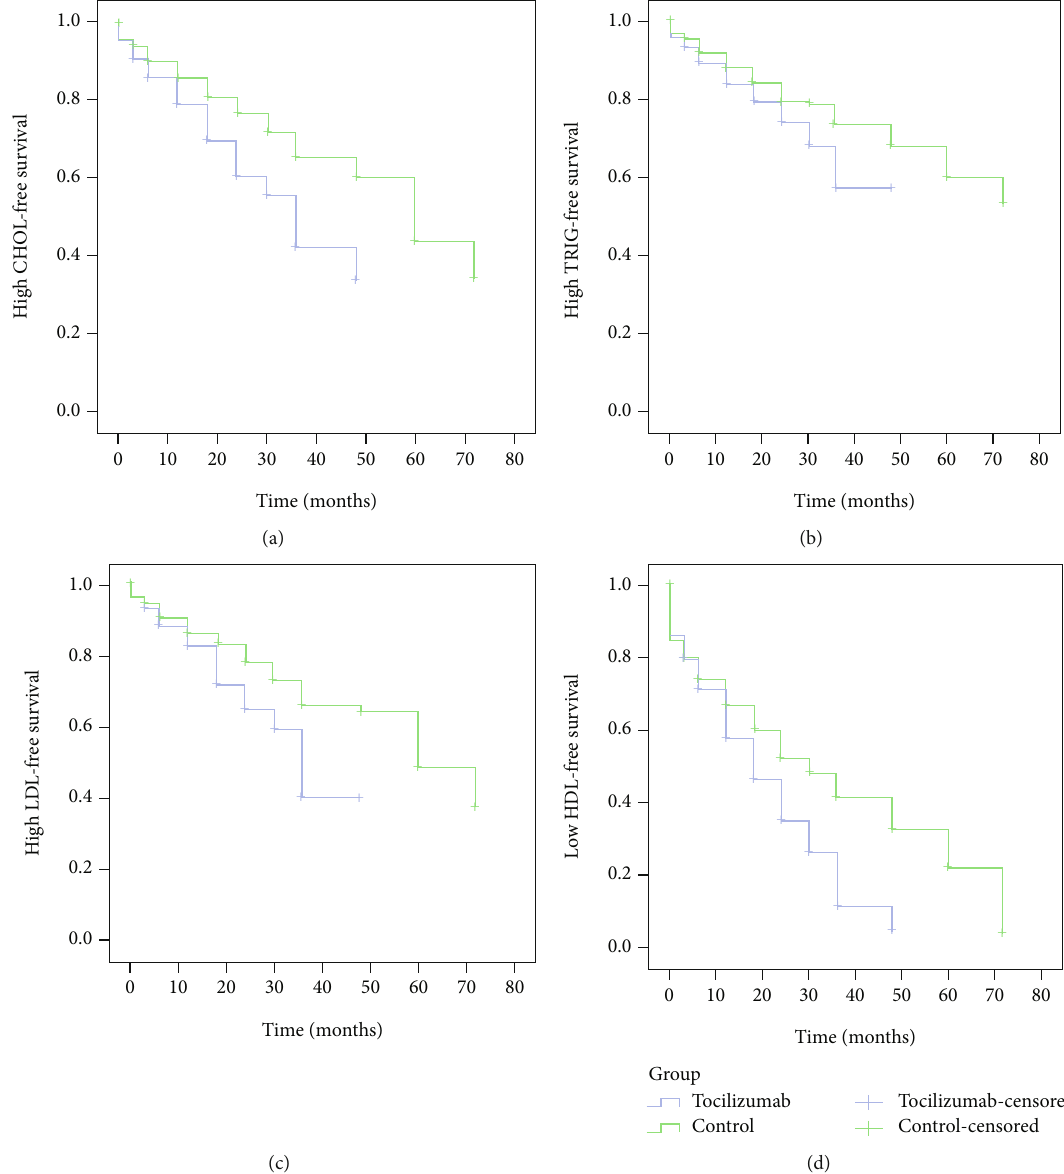
Figure 2: Kaplan – Meier estimate of the time-to-variable lipid pro fi le elevation. (a) The median survival time (high CHOL-free time) for the treatment group was 36 months and for the control group 60 months. The median survival time was signi fi cantly longer in the control than in the treatment group (log-rank test, χ 2 ð 1 Þ = 10 : 71 , P = 0 : 001 ). (b) The median survival time (high TRIG-free time) for the treatment group was 36 months and for the control group 55 months. The median survival time was not signi fi cantly di ff erent between the control and the treatment group (log-rank test, χ 2 ð 1 Þ = 3 : 84 , P = 0 : 05 ). (c) The median survival time (high LDL-free time) for the treatment group was 36 months and for the control group 60 months. The median survival time was signi fi cantly longer in the control than in the treatment group (log-rank test, χ 2 ð 1 Þ = 9 : 10 , P < 0 : 001 ). (d) The median survival time (high HDL-free time) for the treatment group was 18 months and for the control group 30 months. The median survival time was signi fi cantly longer in the control than in the treatment group (log-rank test, χ 2 ð 1 Þ = 20 , P < 0 : 0001